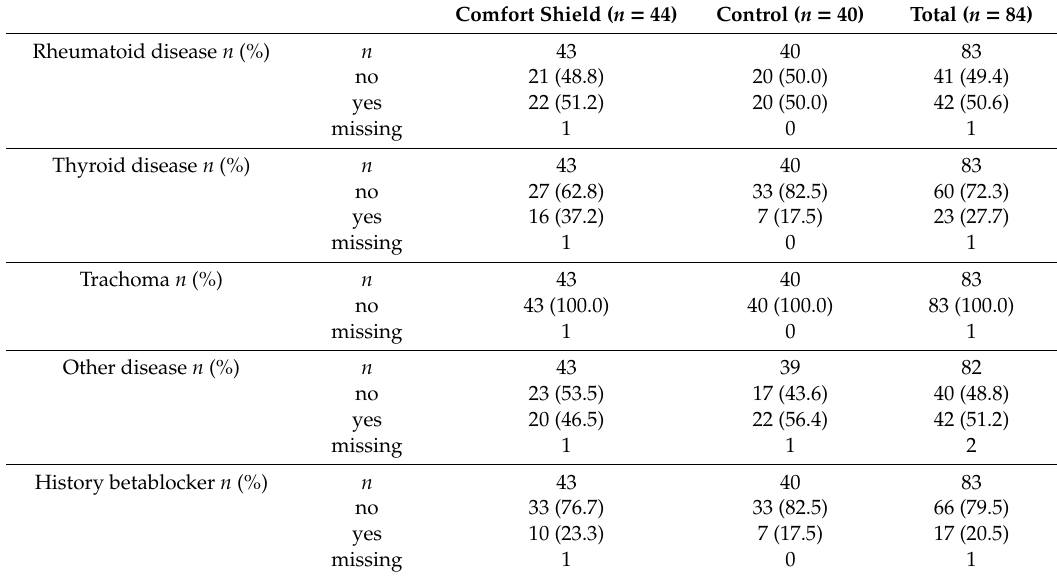
Table A1. Tabular overview of the medical history according to the treatment arm—PPS population ( n =